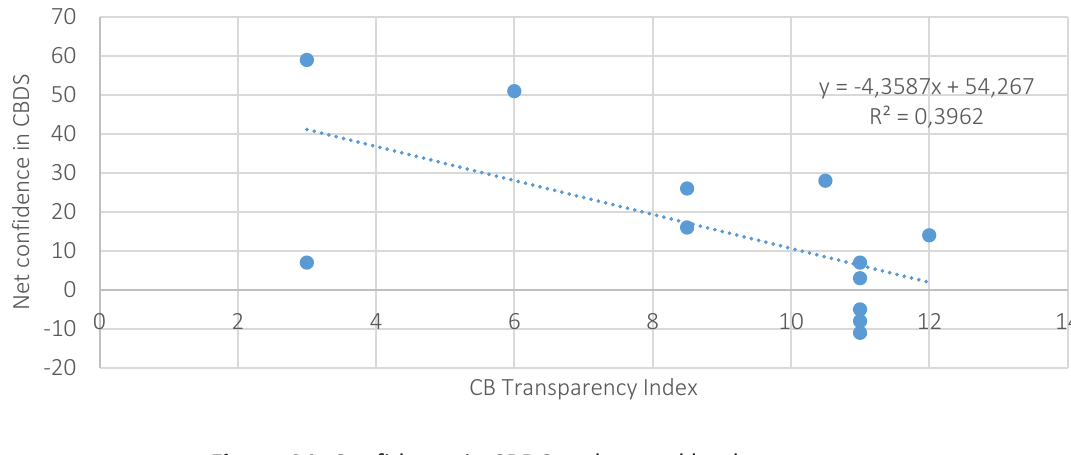
Figure А1. Confidence in CBDC and central bank transparency